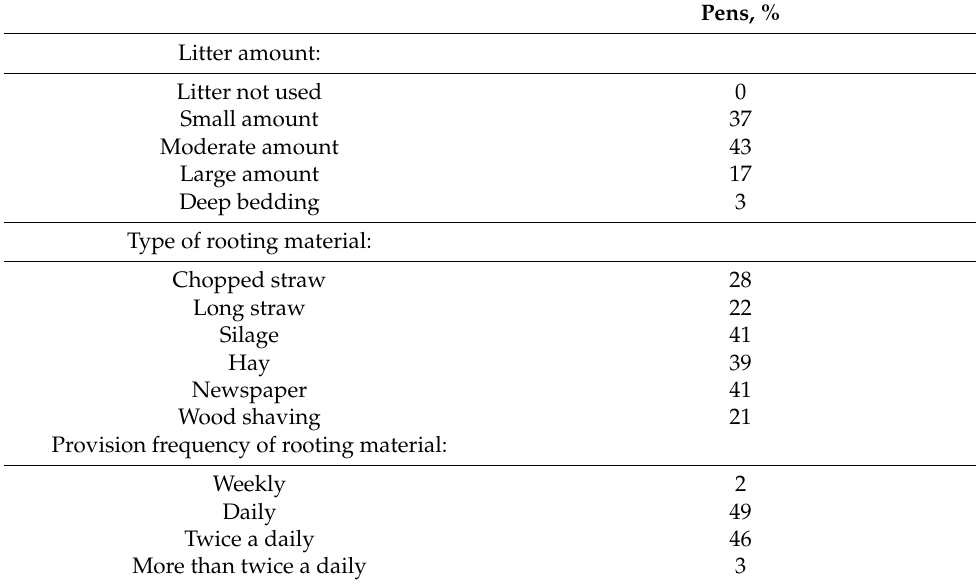
Table 4. Descriptive data for litter amount and rooting material.